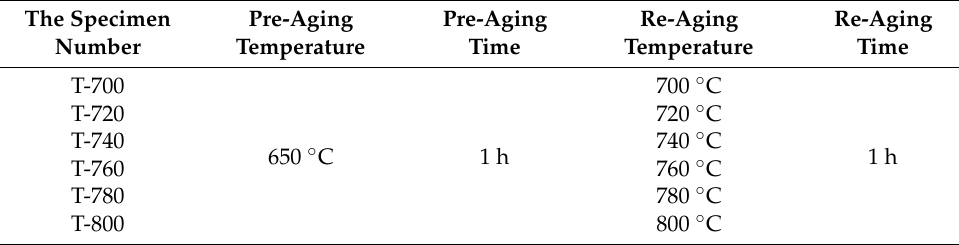
Table 3. Two-stage aging heat treatment process after